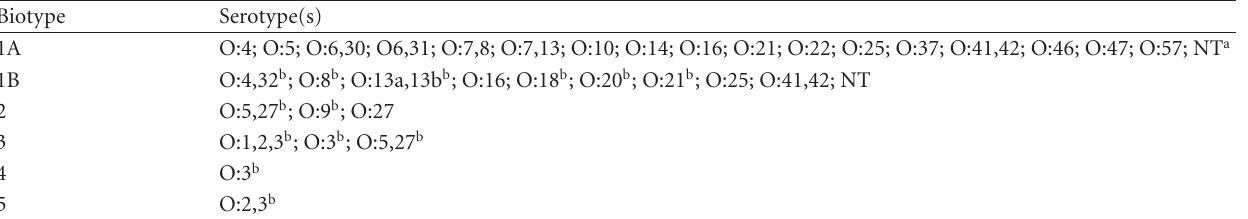
Table 2: Relationship between biotype, O serotype, and pYV carriage of Y. enterocolitica (adapted from Sharon et al. 2003).